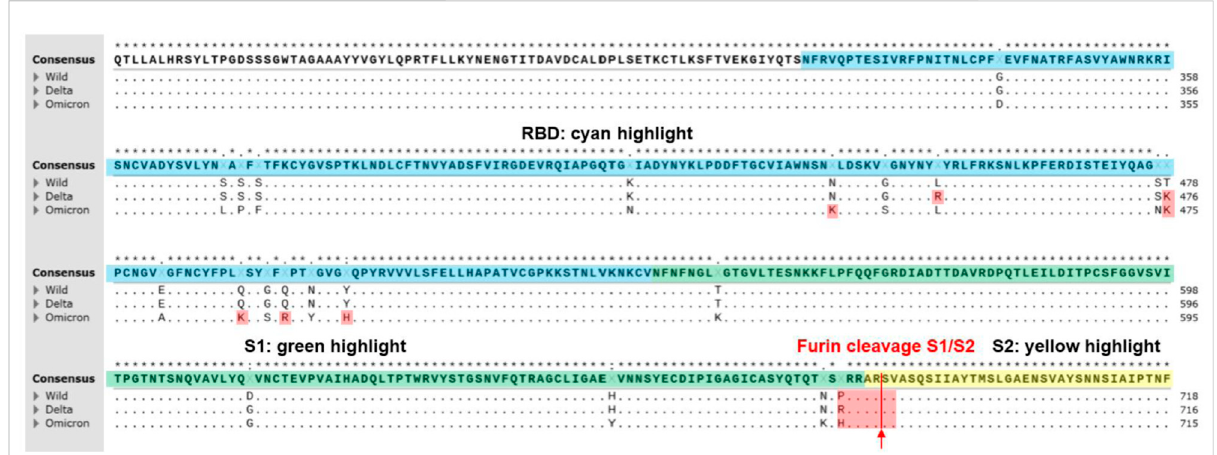
FIGURE 1 A multiple sequence alignment of SARS-CoV2 S-proteins including Alpha, Delta, and Omicron variants reproduced from CLUSTALW. Conservedsequencesshowedthestarsymbol(*)ontop ofconsensussequence.Yellow highlightindicatesN-terminaldomain(13 – 304,NTD).Blue highlightindicatesreceptorbindingdomain(319 – 540,RBD).GreenhighlightindicatesS1subunit(541 – 683).Furincleavagesites(S1/S2sequence)at 684 (PRRAR ↓ SV) were highlighted on red. Positively charged mutations in RBD (L452R and T478K at Delta variant; N440K, T478K, Q493K, Q498R,andY505HatOmicronvariant)andfurincleavagesites(P681RatDeltavariant;P681HatalphaandOmicronvariant)werehighlightedonred. Positively charged mutations (P681H and P681R) at furin cleavage sites of SARS-CoV-2 variants contributed more ef fi cient cleavage ( R RRAR ↓ SV > H RRAR ↓ SV > P RRAR ↓ SV)resultinginincreasedinfectivity(Lubinskietal.,2021).PositivelychargedmutationsinRBDmaycontributetighterbindingto the negatively charged ridges of ACE2 around the binding site of S-protein of SARS-CoV-2 (Prabakaran et al.,